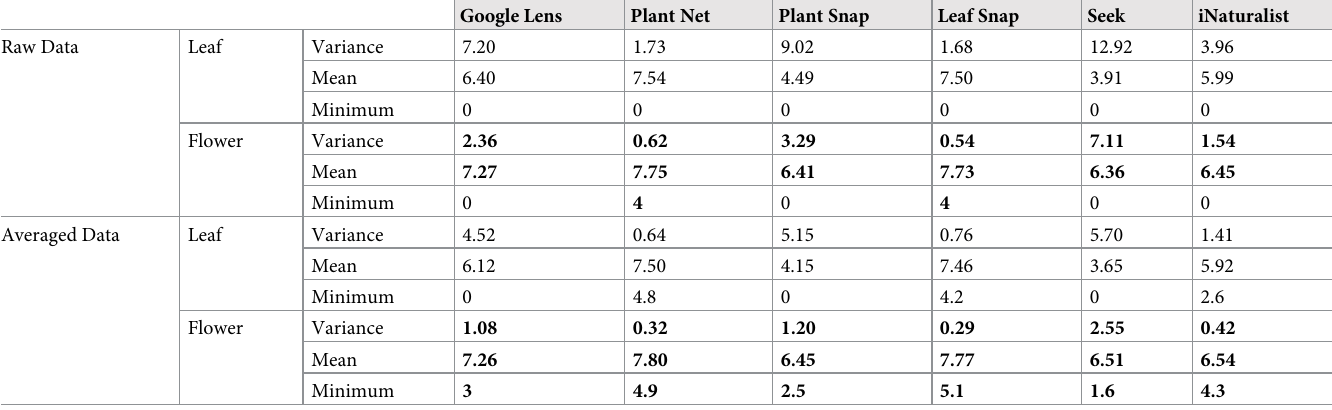
Table 5. Comparison of the mean scores, variance and minimum scores between leaves and flowers across all apps used in the current study.